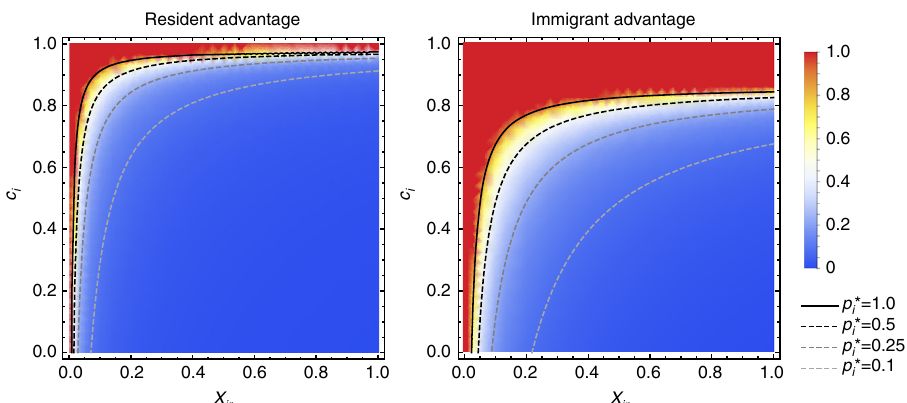
Fig. 3 Equilibrium with constant payoff differences. The equilibrium frequency of trait that is initially associated with immigrants (type I) when it has a payoff advantage (immigrant advantage, right) or a payoff disadvantage (resident advantage, left). Both lines and colours depict the equilibrium frequencies of the immigrant trait as calculated using the analytical model. Solid lines show the boundary between the coexistence equilibrium and the ¼ 1). In both graphs c r = 0.95, W = 1 and m = 0.01 equilibrium where the type I trait becomes fi xed ( p (cid:5) 0 i